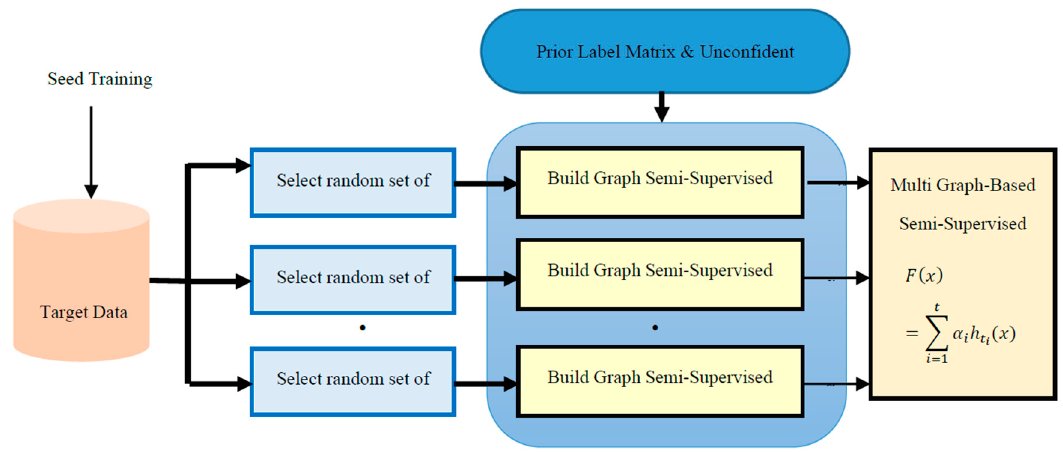
Figure 1. Multi-Graph Semi-Supervised Learning with Prior Label Information.